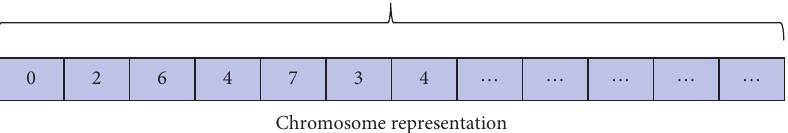
Figure 1: Schematic diagram of chromosome